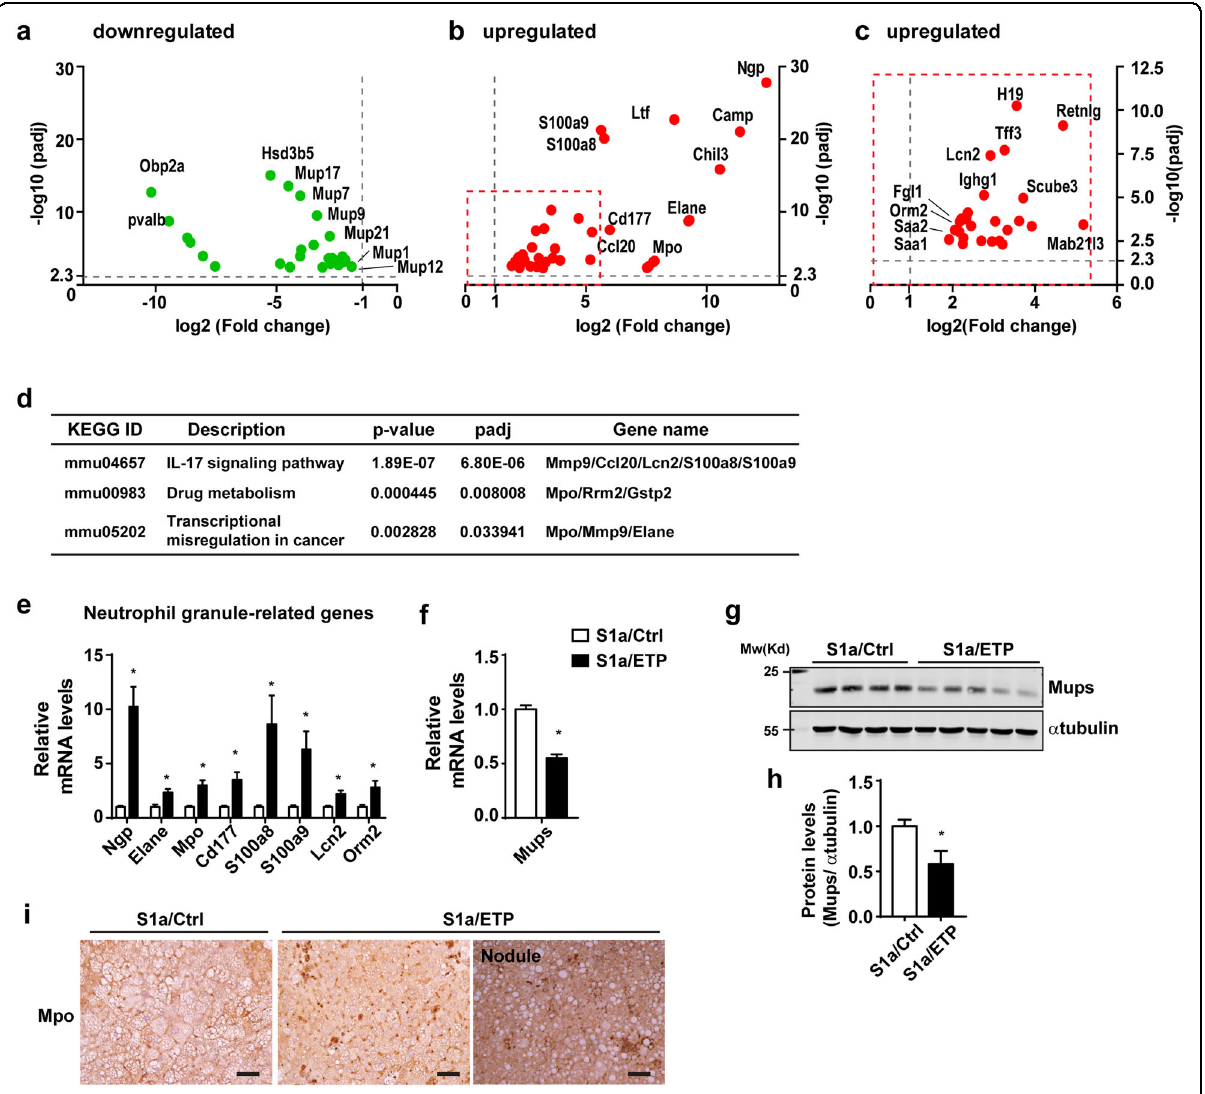
Fig. 4 Differential gene expression in the S1a/ETP transgenic mice. a – c Volcano plot of differentially expressed genes between the two groups. d KEGG pathway analysis of these genes. e , f Con fi rmation of up- or downregulated genes by qPCR. g , h Con fi rmation of the Mup protein levels in the livers of the S1a/Ctrl and S1a/ETP mice. i Immunostaining for MPO. Bars: 150 µm. * p < 0.05 vs. the livers of the Ctrl mice. ** p < 0.05 vs. the livers of the S1a/Ctrl